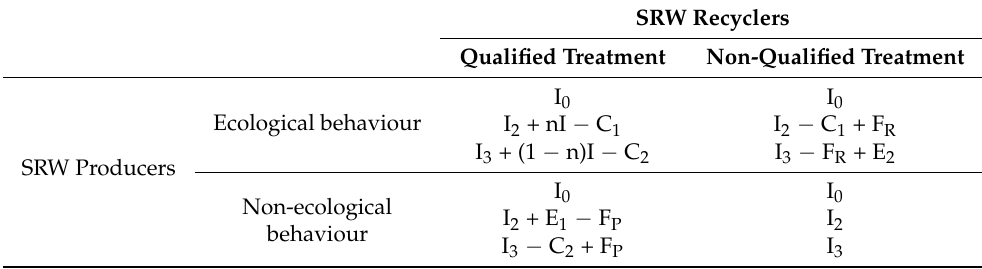
Table 3. Payoff matrix with governments that choose negative